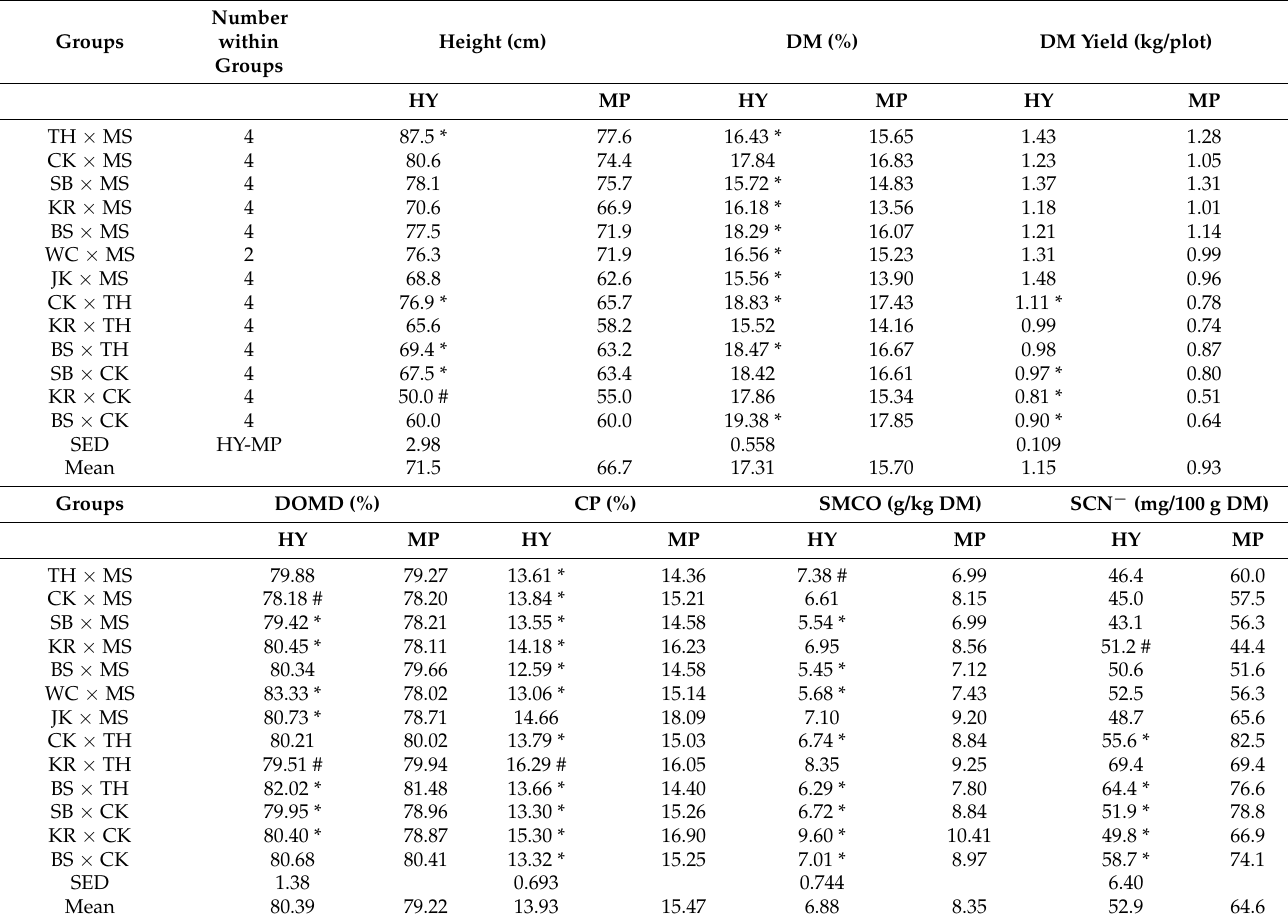
Table 3. Comparison of means of groups of hybrids (HY) with their mid-parent (MP) values.